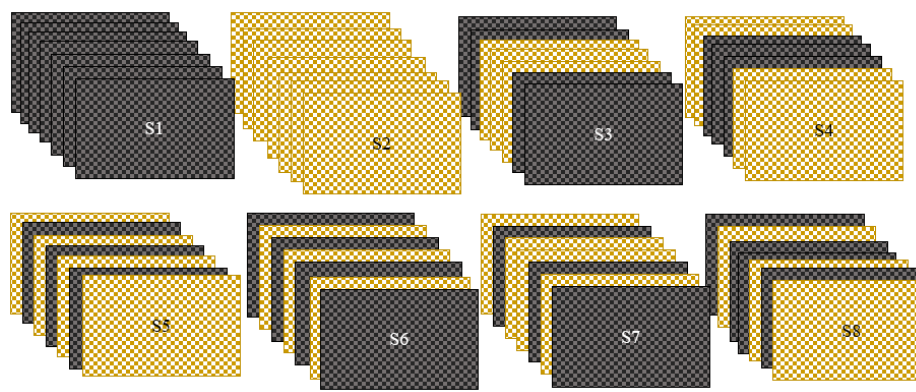
Figure 2. Stacking sequence of composite laminates. (S1-BBBBBBBB; S2-RRRRRRR; S3-BBRRRBB;